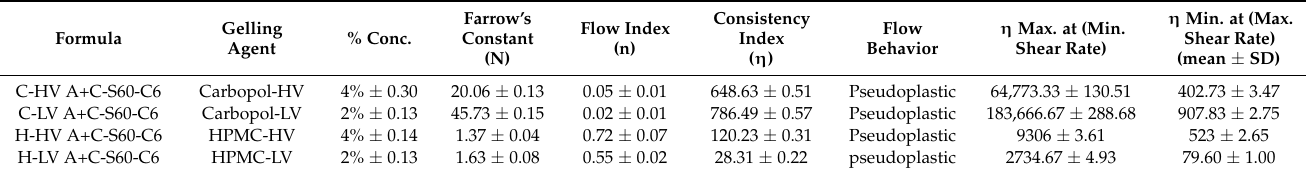
Table 6. Rheological data and viscosity measurements of combination ACZ and CAR loaded niosomes gel formulations ( n = 3). Formula Gelling Agent % Conc. C-HV